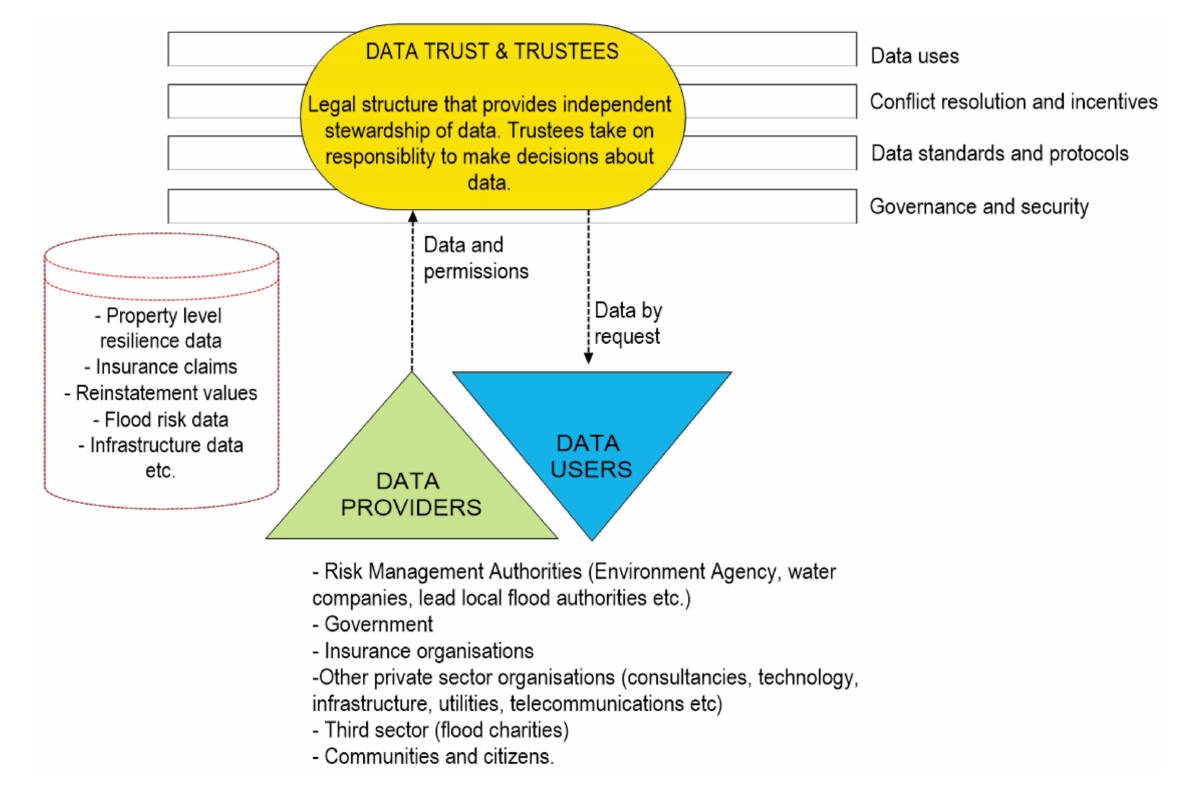
Figure 1. Data trust in the context of flooding in the UK. Table 1. Challenges preventing data sharing